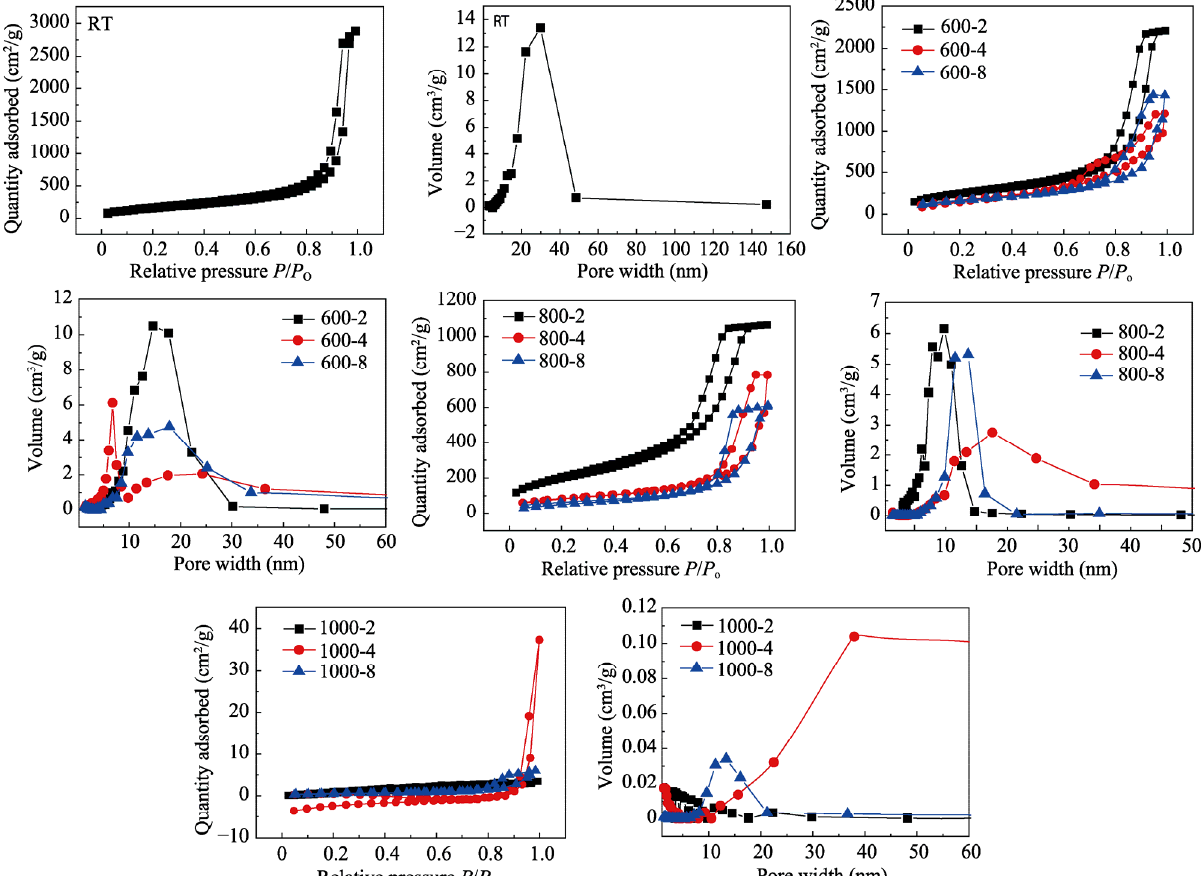
Fig. 6 N 2 adsorption/desorption isotherms and the PSD of SiO 2 aerogels before and after thermal